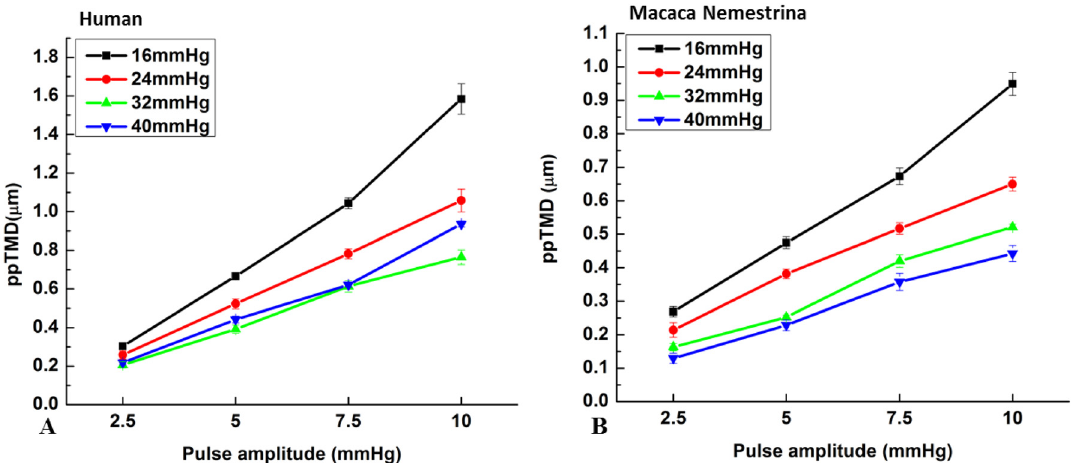
Figure 3. The mean and standard deviation of the peak-to-peak trabecular meshwork displacement (pptTMD) from applying various mean pressure and pulse amplitudes. A separate color specifies each mean pressure, and each data point is the average of 4 measurements. ( A ) is captured on cadaver human eye. ( B ) is captured on Maca Nemestrina.